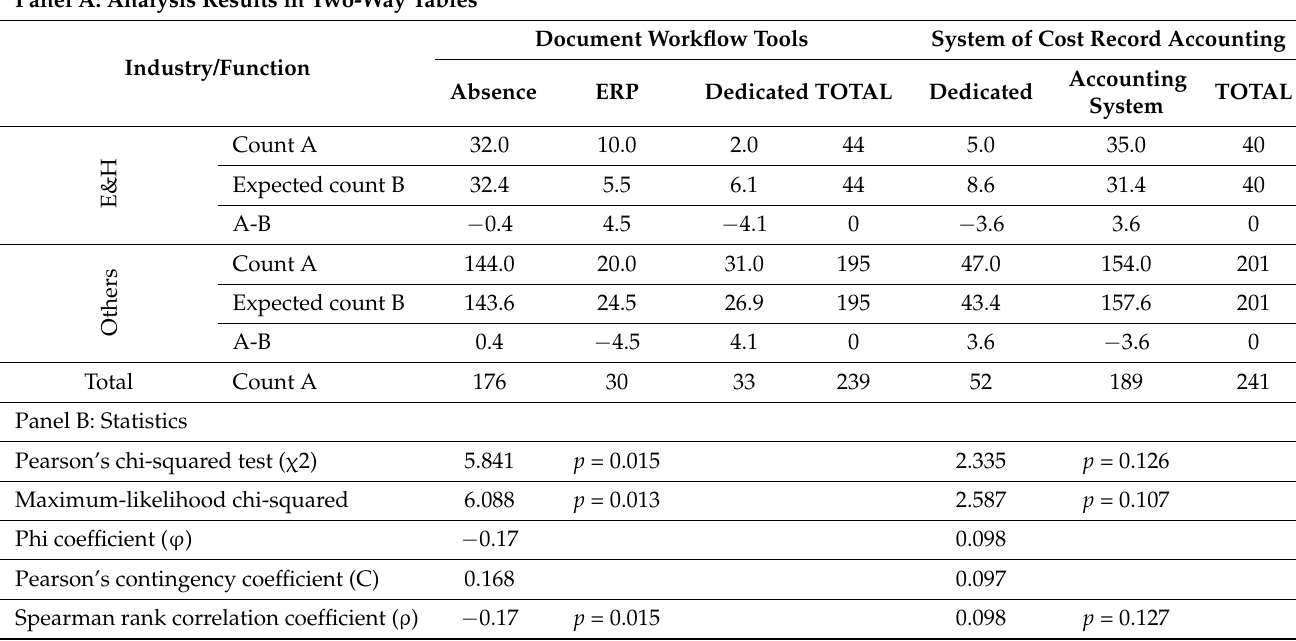
Table 6. Accounting record tools used in the surveyed